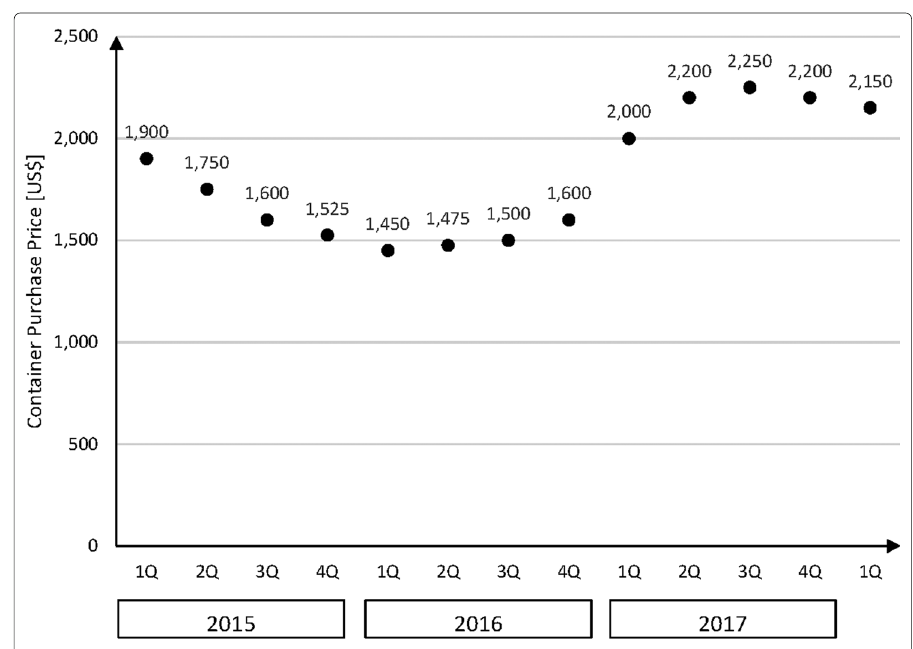
Fig. 2 Average price of a new 20ft container; Data source: Drewry Shipping Consultants